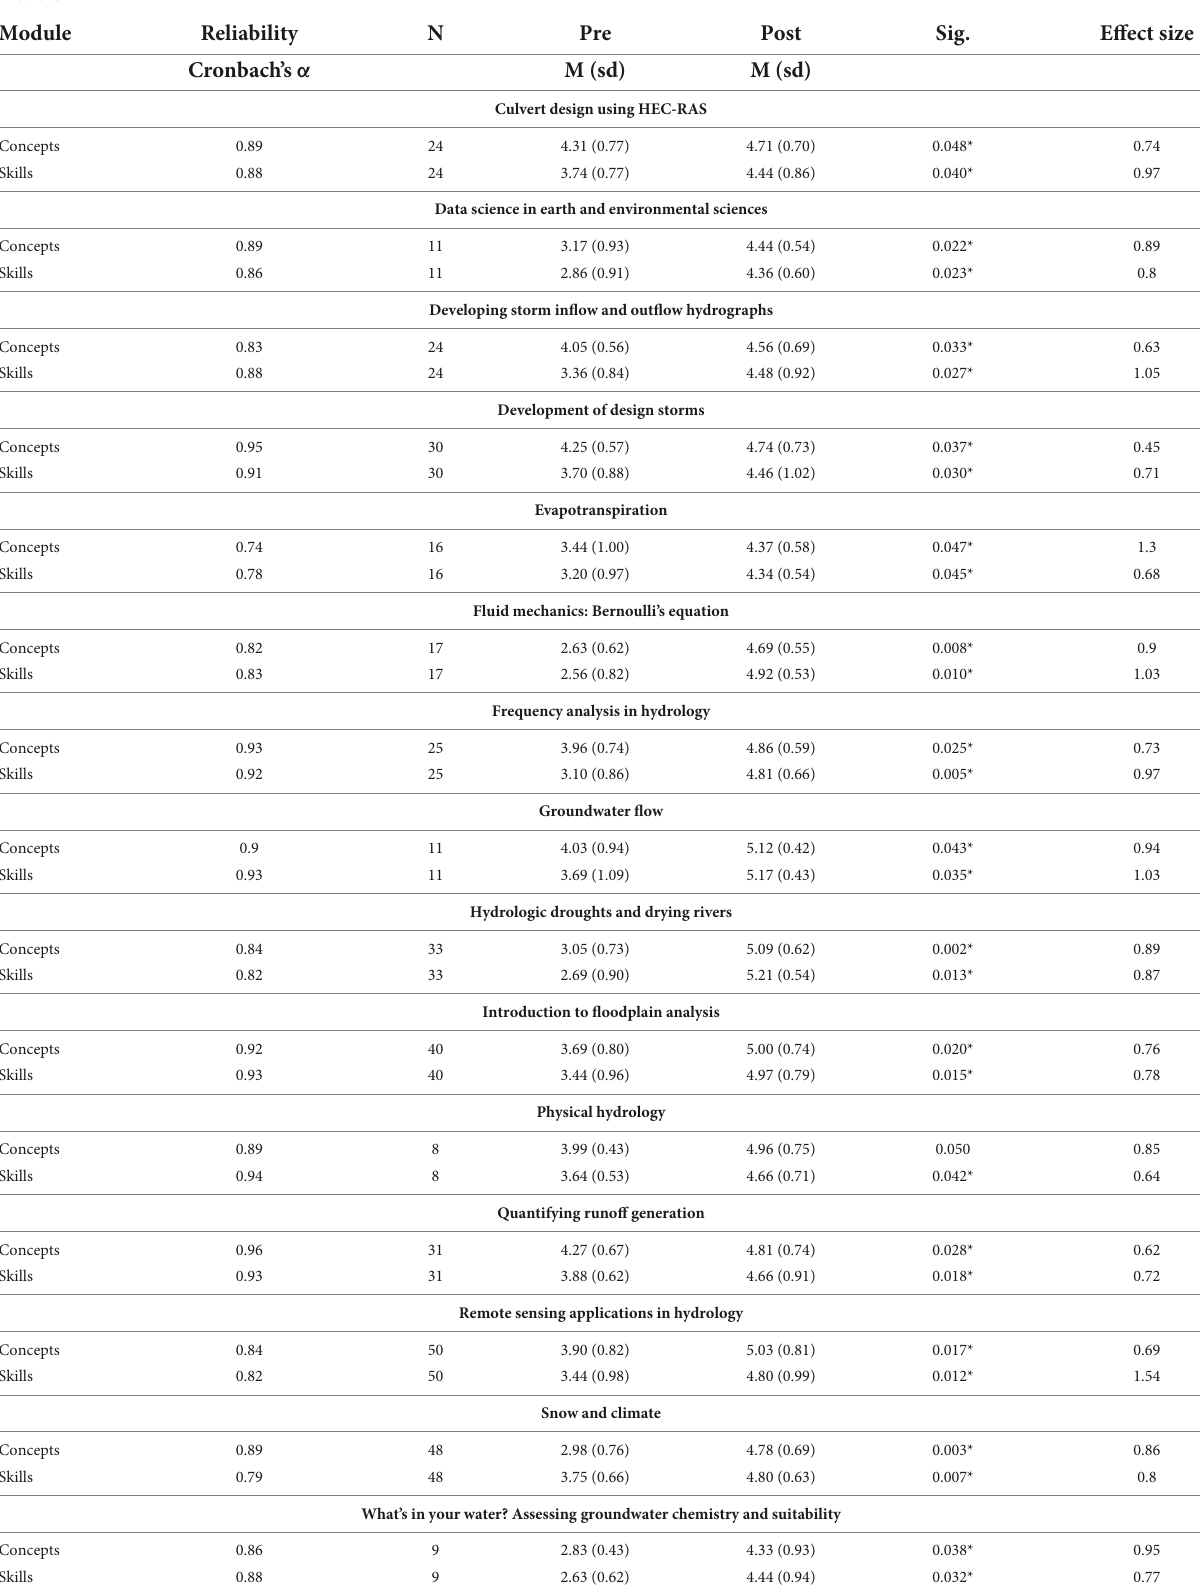
TABLE 2 Reliability, pre- and post-mean scores and standard deviations, significance, and the effect size (Cohen’s d or r equivalent ) organized by module.